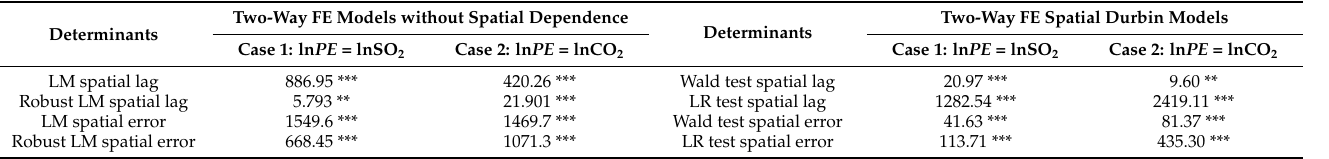
Table 5. Diagnostic tests of spatial